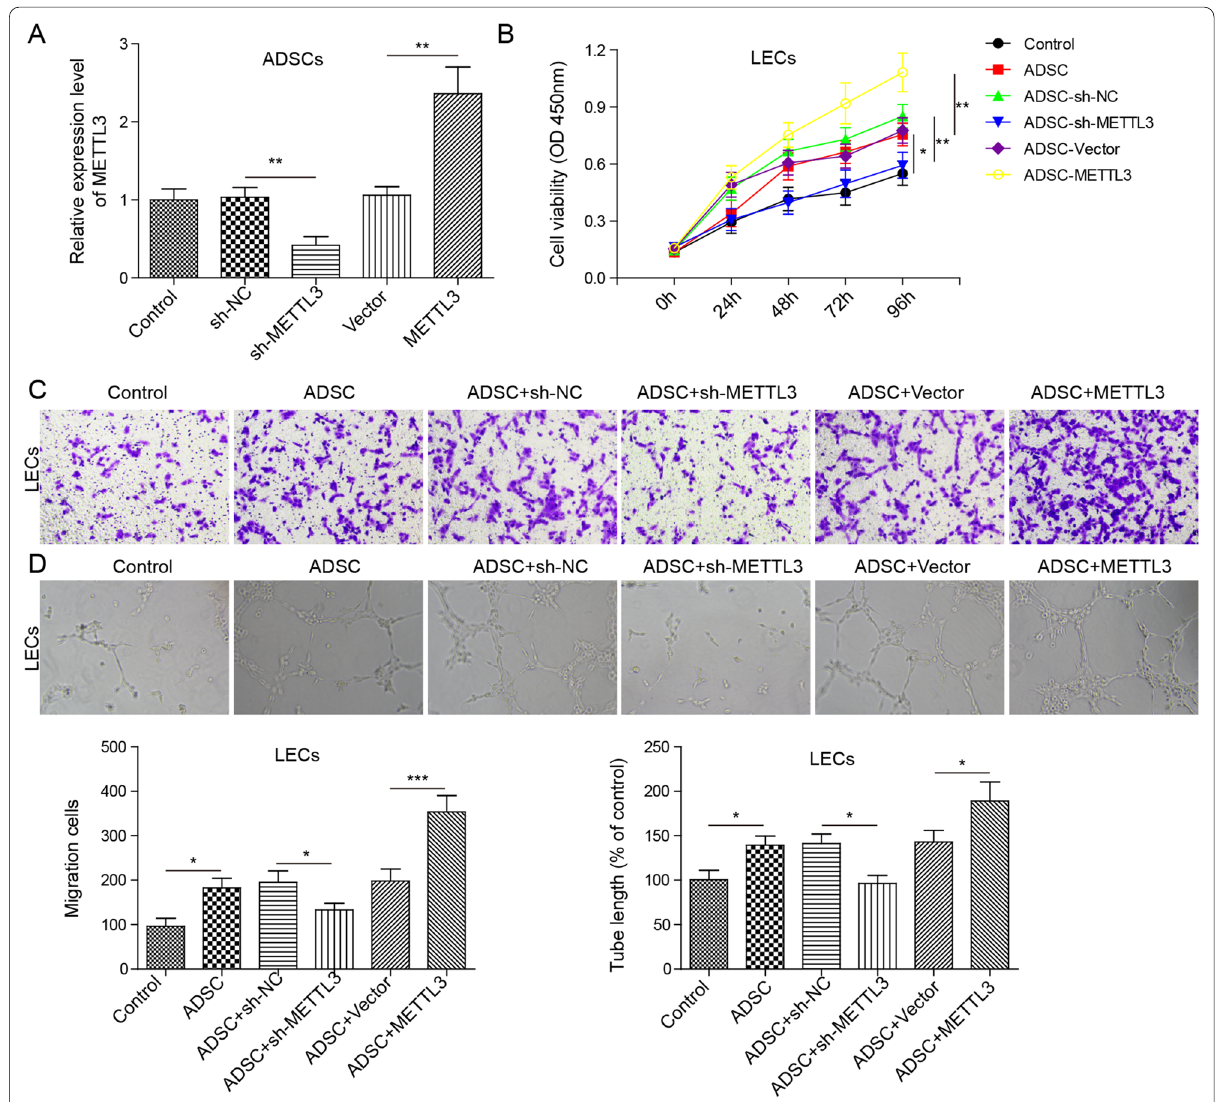
Fig. 2 ADSCs accelerate LEC proliferation, migration and lymphangiogenesis via the METTL3 pathway. sh-METTL3 and pcDNA-METTL3 plasmids were transfected into ADSCs for METTL3 knockdown and overexpression, respectively. sh-NC served as the negative control for sh-METTL3 plasmids, and pcDNA-empty vector served as the negative control for pcDNA-METTL3 plasmids. Subsequently, LECs were stimulated with ADSC-CM for 24 h. A RT-qPCR was performed to assess the levels of METTL3. B CCK-8 was conducted to assess LEC viability. C Transwell assays were carried out to evaluate LEC migration. D A tubule formation assay was performed to assess the tubule formation ability of LECs. Data represent the mean of three independent experiments. Error bars represent SD. * P < 0.05, ** P < 0.01 or *** P <